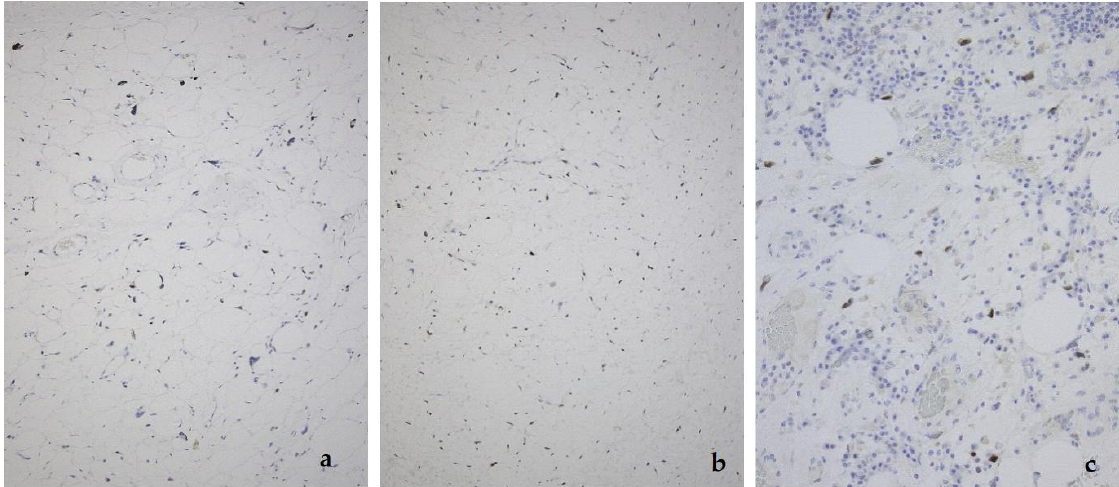
Figure 4. Ring chromosome in well-differentiated liposarcoma/atypical lipomatous tumor. The ring contains multiple cop- ies of the MDM2 and CDK4 gene.